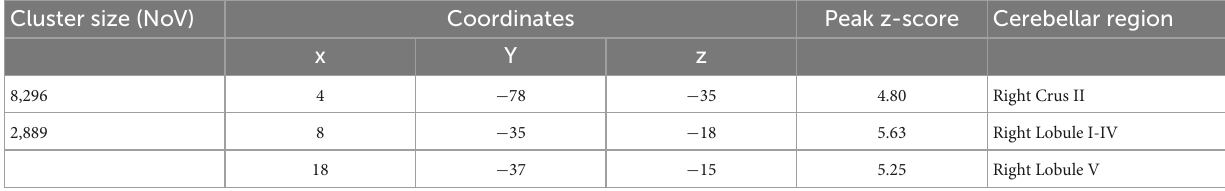
TABLE 3 Detailed statistics of voxel wise comparisons of cerebellar GM density (BD < HS-MRI). Cluster size (NoV) Coordinates Peak z-score Cerebellar